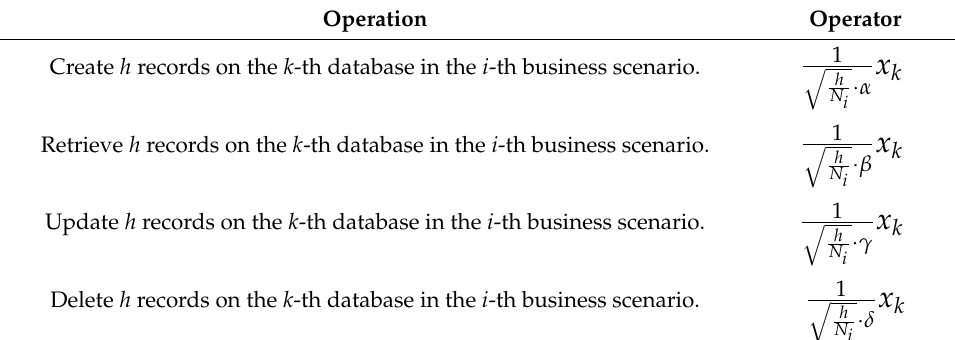
1 x (cid:113) k h · α Ni 1 x (cid:113) k h · β Ni 1 x (cid:113) k h · γ Ni 1 x (cid:113) k h · δ Ni